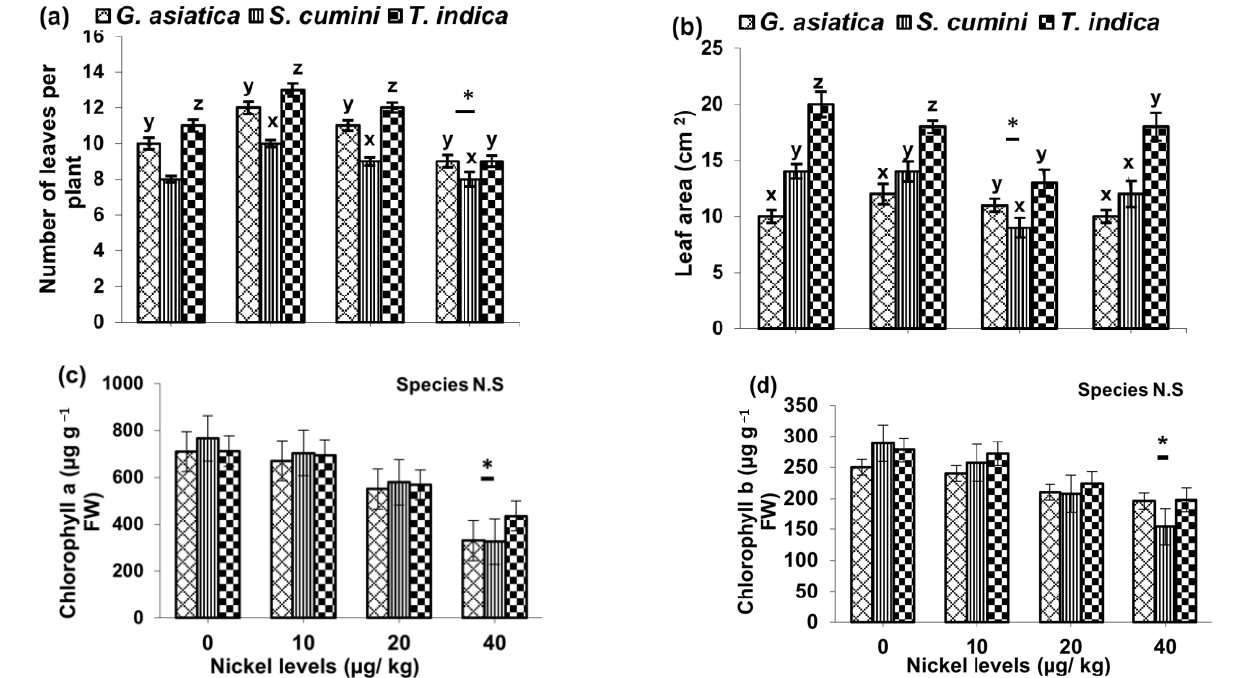
Figure 1. Photosynthetic attributes: leaf number ( a ), leaf area ( b ), chlorophyll a ( c ) and chlorophyll b ( d ) in three minor fruit species ( Grewia asiatica L., Syzgium cumini (L.) Skeels and Tamarindus indica L.) after exposure to increasing levels of Ni in the growth medium. Each mean is across three replicates with ± S.E. Different letters on each bar indicate significant difference between species (x–z), and * on each level shows a marked variability from the control, analyzed through two-factor ANOVA, with equal number of replications, followed by a post hoc multiple comparison test (DMRT).